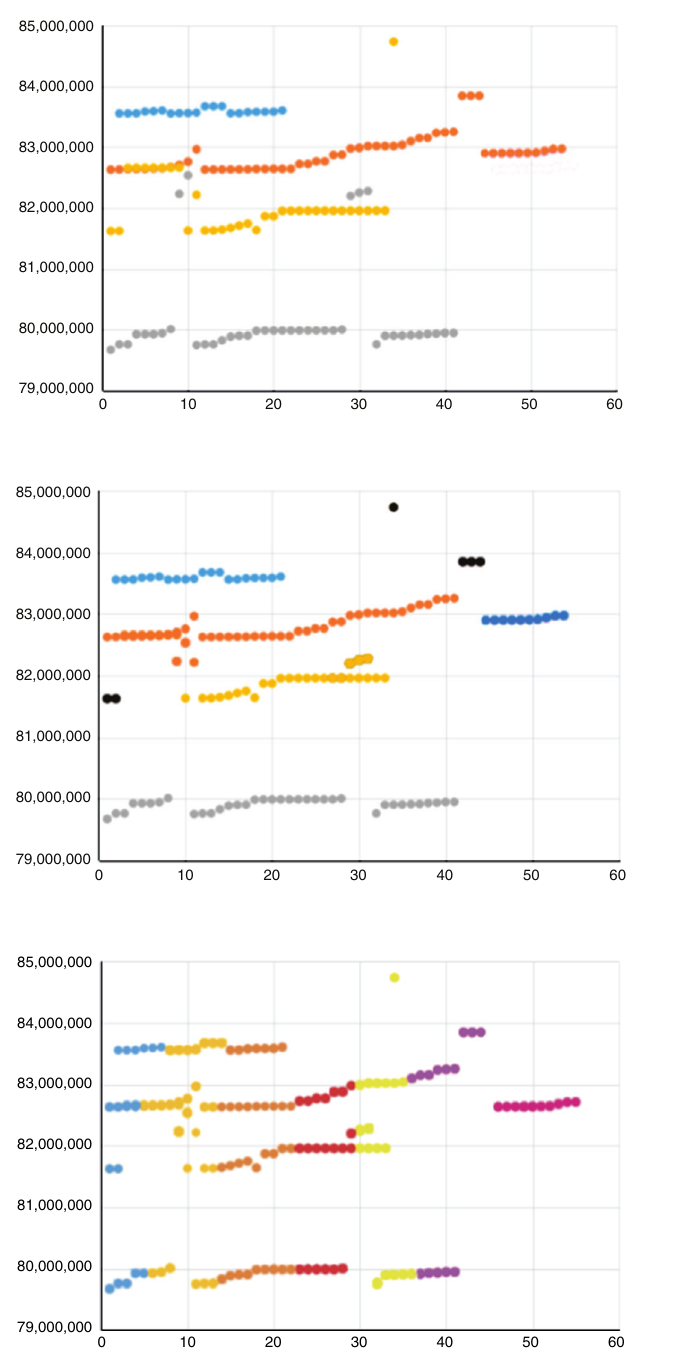
Figure 18. Result of average-link on “ MOOCs ” data